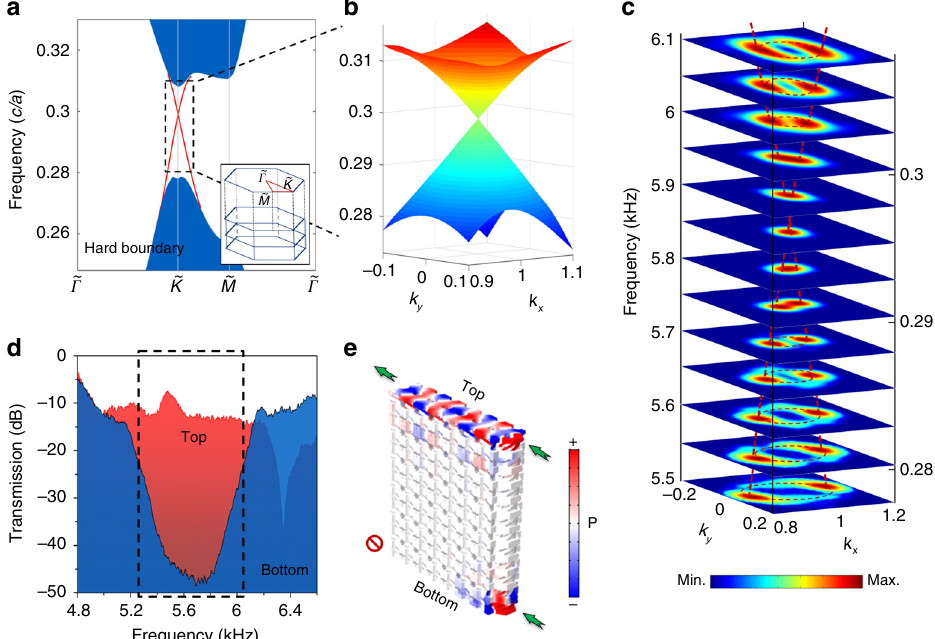
Fig. 3 Topological surface in the xy plane. a Projected bandstructures in the k xy plane with a hard boundary condition, where the red lines represent surface states. The inset shows the surface Brillouin zone. b 3D view of the simulated surface Dirac cone. Here, k x and k y have units of 4 π /9cm − 1 . c Experimentally measured iso-frequency slices with Bloch momenta for the surface states. The colour scale represents the acoustic energy density. The dashed lines are drawn to guide the eye. d Measured transmission spectra for the top (red) and bottom (blue) surfaces along the ~ Γ ~ K direction, where the colour scale represents the energy density. e A slice of the simulated acoustic pressure distribution with acoustic source excited at both top and bottom surfaces at a frequency of 5.8kHz, where the colour scale represents the acoustic